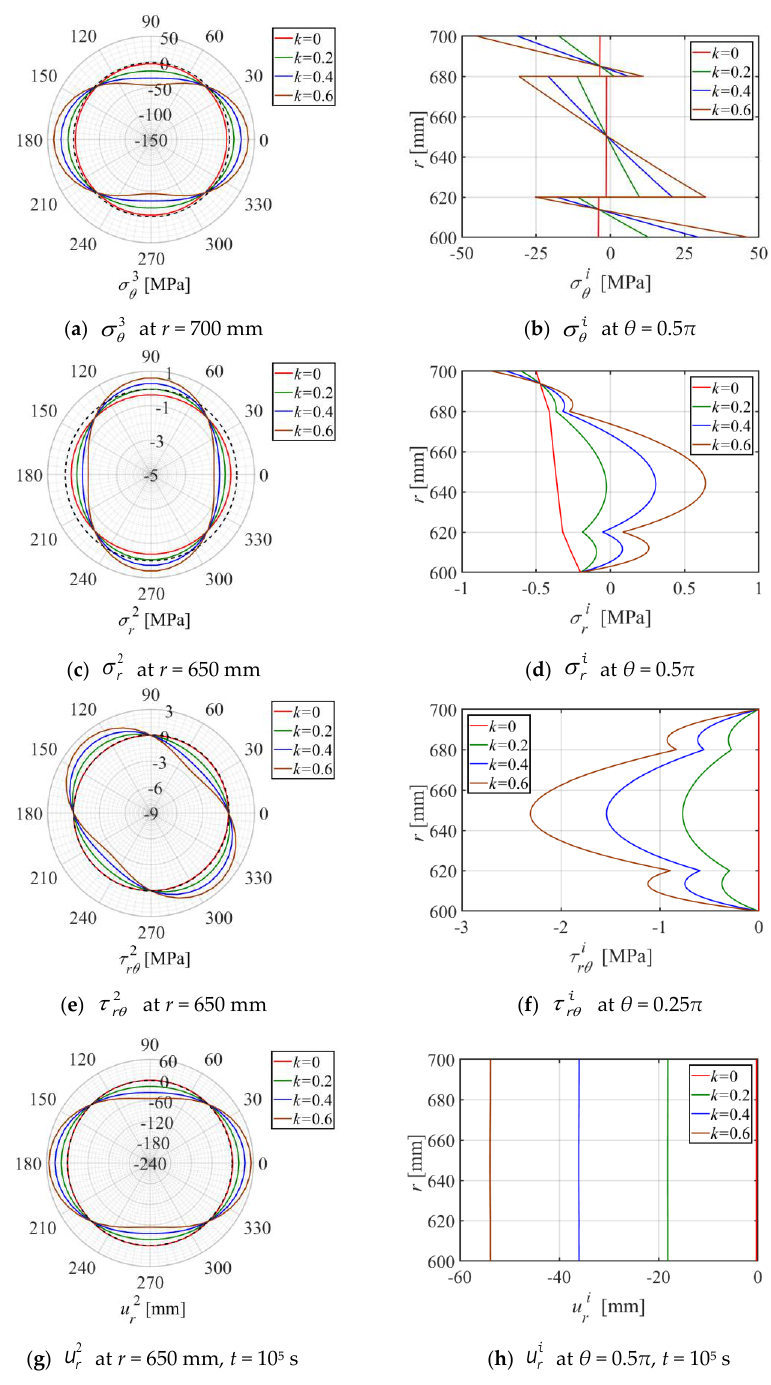
Figure 8. The stresses and displacement distribution along the pipe thickness and circumferential direction with different load uniformity degree. As shown in Figure 8, for the uniform case of k = 0, i , small values, while these values increase remarkably as k increases. Along the circum- ference of the pipe, the changes in stresses and displacements follow the shapes of trig- onometric functions, and the location of each maximum has a difference of π /2 from the location of its respective minimum. The maxima of i , i r , i r , and i r u happen at θ = 0, π /2, 3 π /4, and 0, respectively. Through the thickness direction of the pipe,